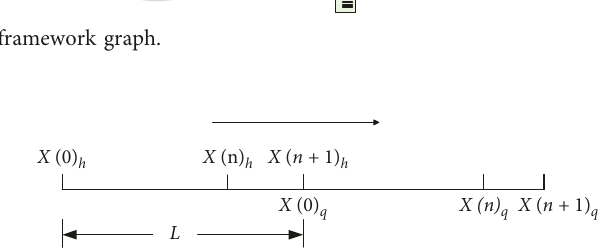
Figure 1: System framework graph.